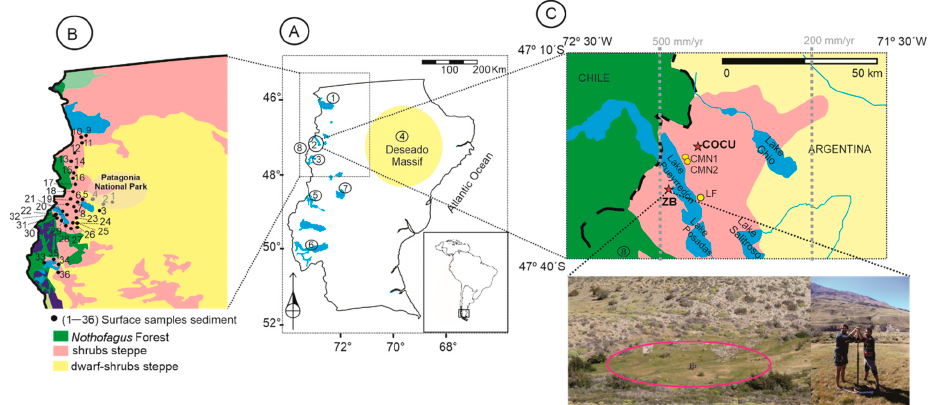
Figure 1. ( A ) Map of South America and Santa Cruz, Argentinian Patagonia, that shows the geographical location of the study site and other paleoenvironmental records used in regional paleoenvironmental reconstruction. 1—Buenos Aires Lake [21]; 2—Pueyrredón Lake [22–24,26,27]; 3—Belgrano Lake (PNPM) [37]; 4—The Deseado Massif [20,32]; 5—San Martín Lake [18,19]; 6—Argentino